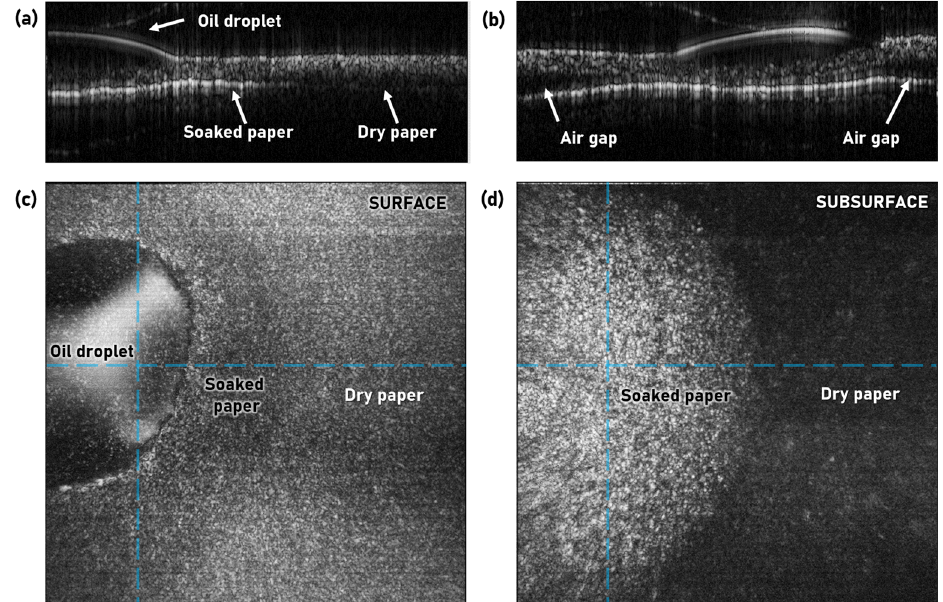
Figure 9. OCT imaging of oil contamination on 68- μ m paper sample. ( a , b ) Orthogonal B-scans near the oil droplet corresponding to the horizontal and vertical dashed lines seen in ( c , d ), respectively. ( c , d ) Top-view volume projections of the sample surface and subsurface region (excluding the mirror), respectively.